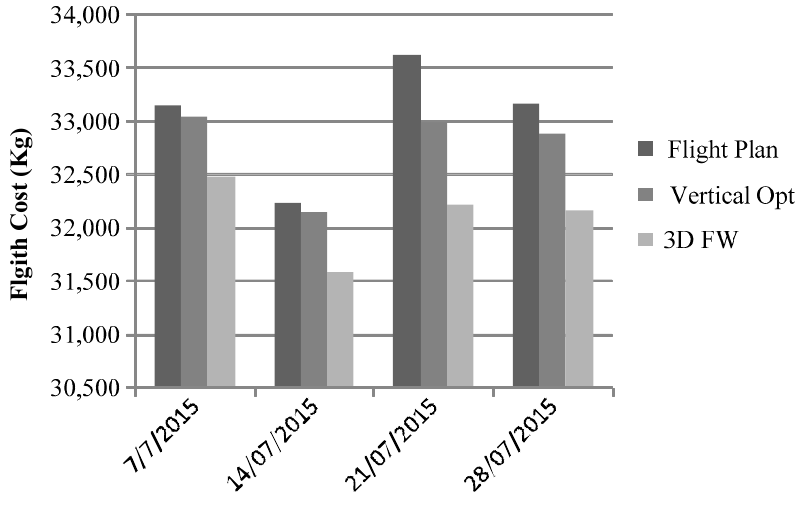
Figure 12. Flight cost differences between reference flight, optimized vertical flight, and optimized 3D FW flight trajectories. Flight optimization for different as ‐ flown flights.